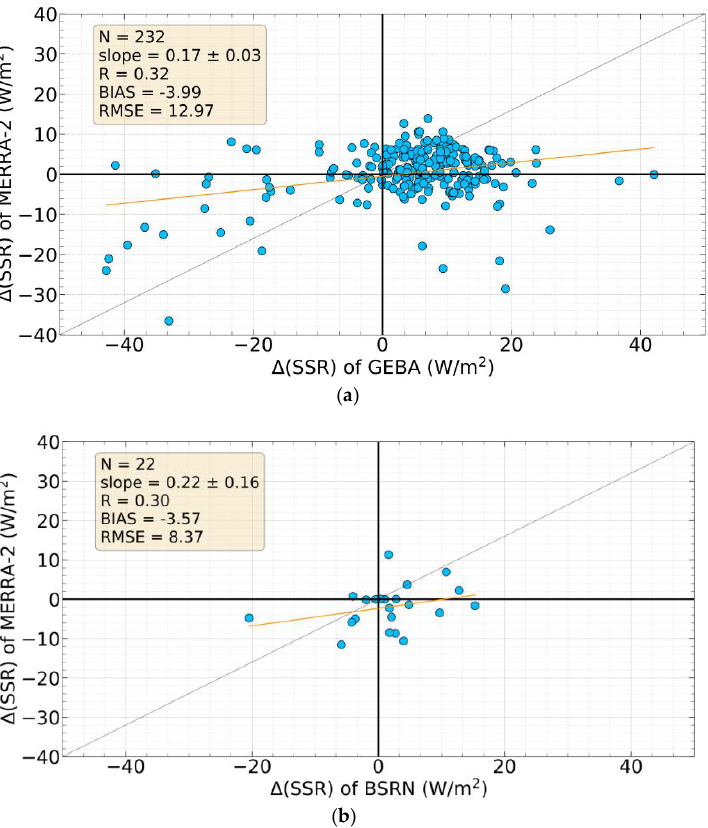
Figure 6. Scatterplot comparison between MERRA-2 and GEBA ( a ), and MERRA-2 and BSRN ( b ) Δ(SSR) or GDB (in W/m 2 ). The linear regression fit, and the associated statistical metrics, namely the slope, the slope error, the correlation coefficient (R), the root-mean squared error (RMSE), the bias (MERRA-2 minus stations) and the total number of matched data pairs, are also